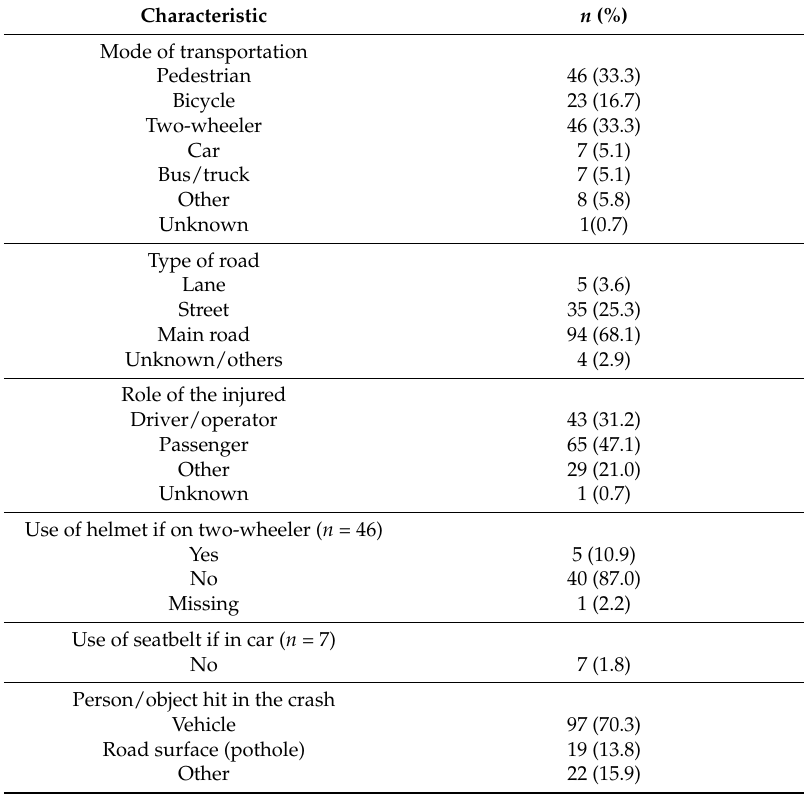
Table 2. Characteristics of road traffic injuries ( n =